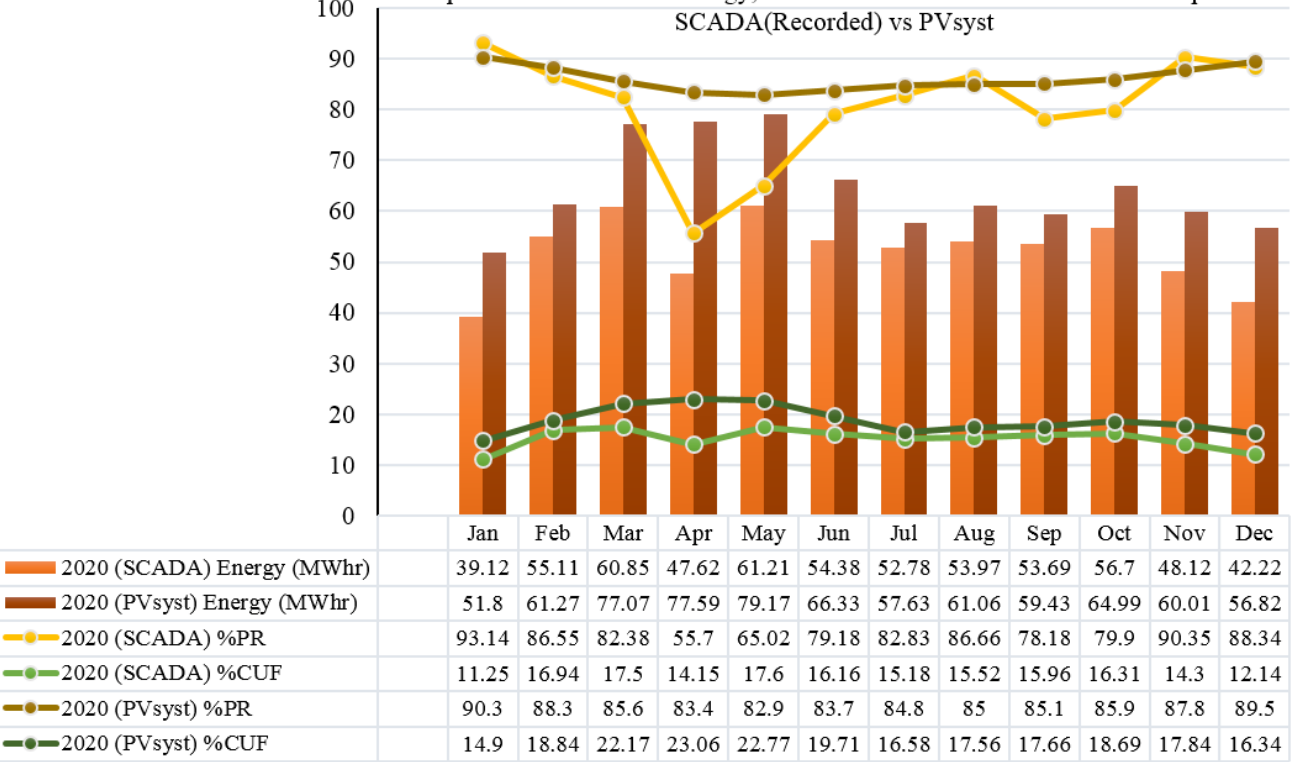
Figure 10 . Comparison of Generated Energy, %PR and %CUF in 2020 from 467.2 kWp Plant: SCADA (Recorded) vs. PVsyst .